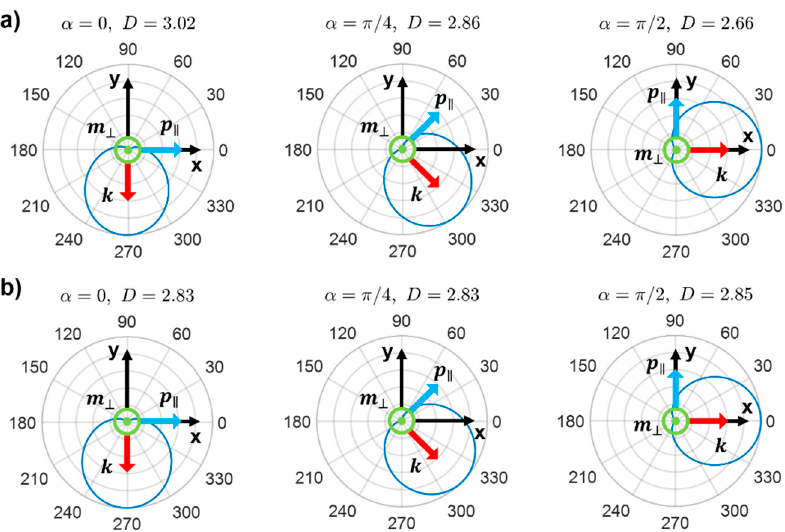
Figure 3. The far-field radiation pattern of the silicon nanodisk under different coherent excitations. The working wavelength is 600 nm ( a ) and 633 nm ( b ). The polarization angles for v T ( α ) are (from left to right) α = 0, π /4, and π /2, respectively. Their directivities are calculated to be: 3.02 ( α = 0), 2.86 ( α = π /4), and 2.66 ( α = π /2) for 600 nm excitation, and 2.83 ( α = 0), 2.83 ( α = π /4), and 2.85 ( α = π /2) for 633 nm excitation, respectively.